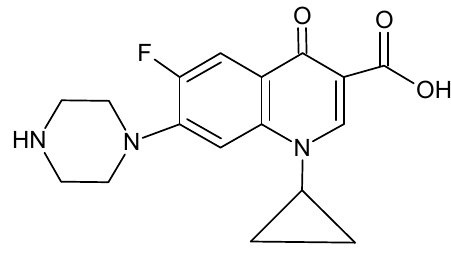
Figure 7. Structure of co-trimoxazole.